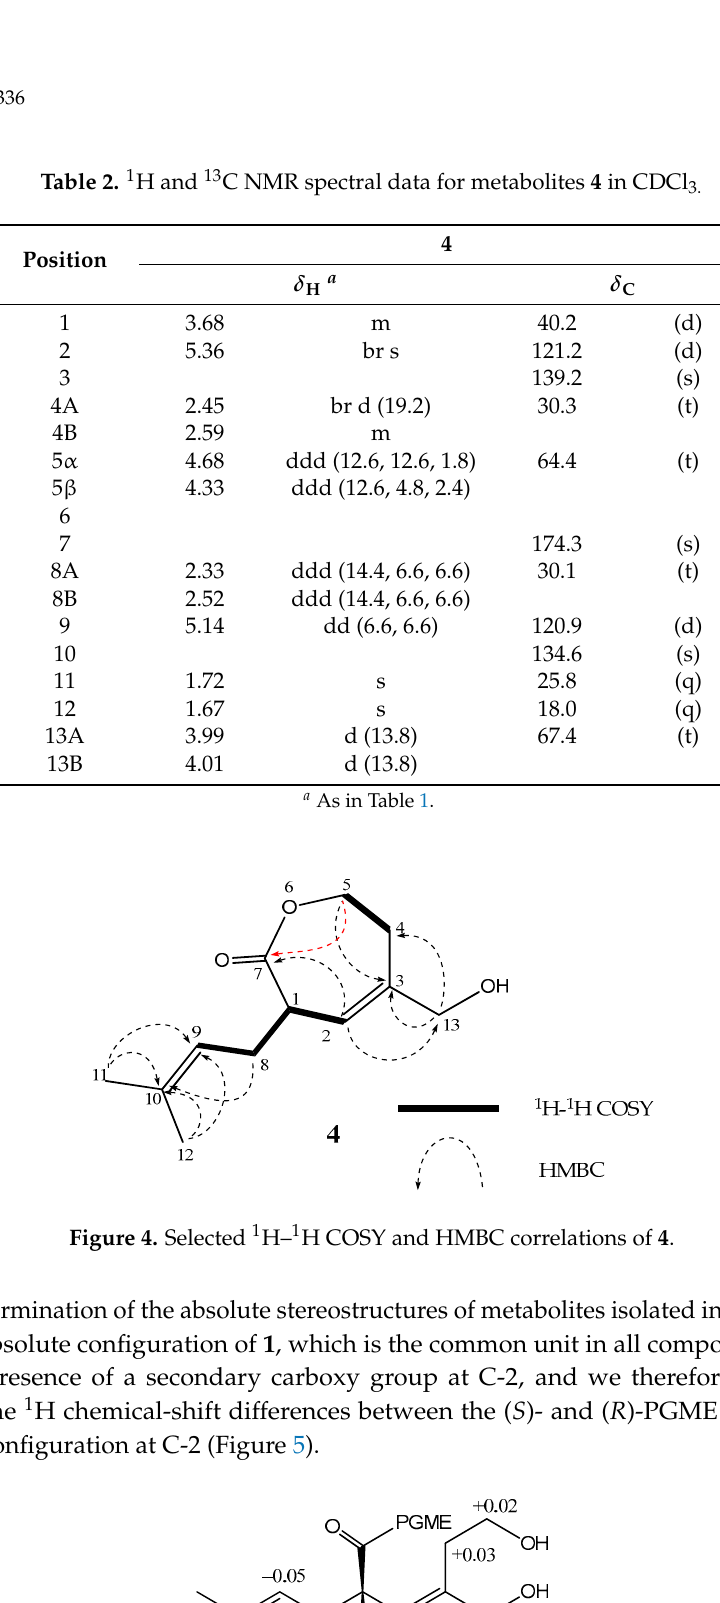
Table 2. 1 H and 13 C NMR spectral data for metabolites 4 in CDCl 3.